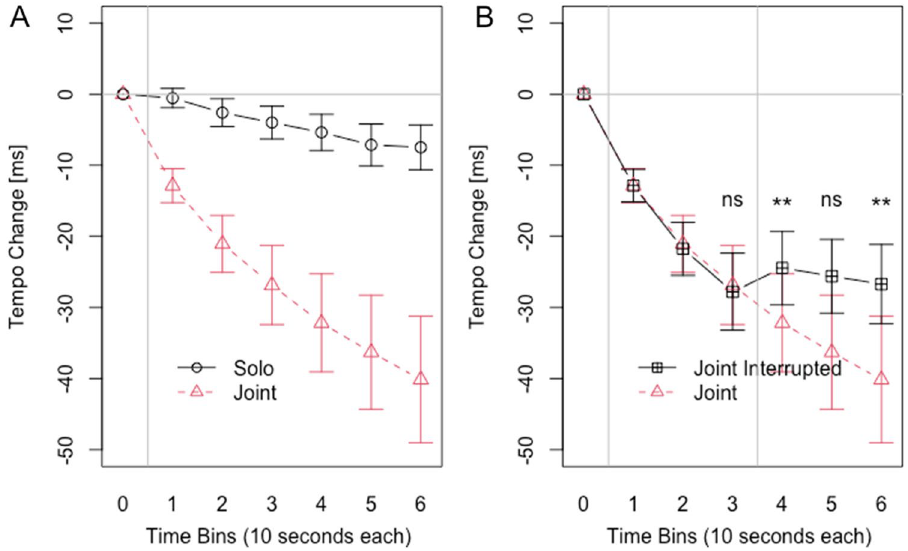
Figure 2. Similar to Fig. 1, but the data comes from musicians. ( A ) Participants became faster in the Joint condition than in the Solo condition. ( B ) In the joint interrupted condition where the auditory feedback of the partner’s taps stopped after Time Bin 3 the tempo increase immediately stopped. The tempo increase continued in the joint condition in which participants continued to receive auditory feedback of the partner’s